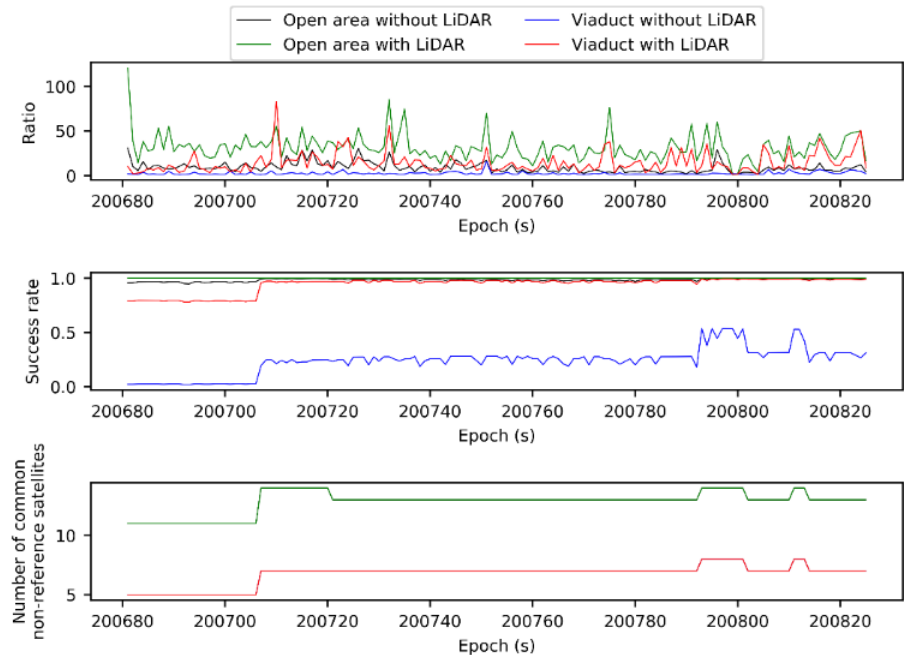
Figure 8. Time series of ratio values, success rate and the number of common reference satellites between the two vehicles for four cases.